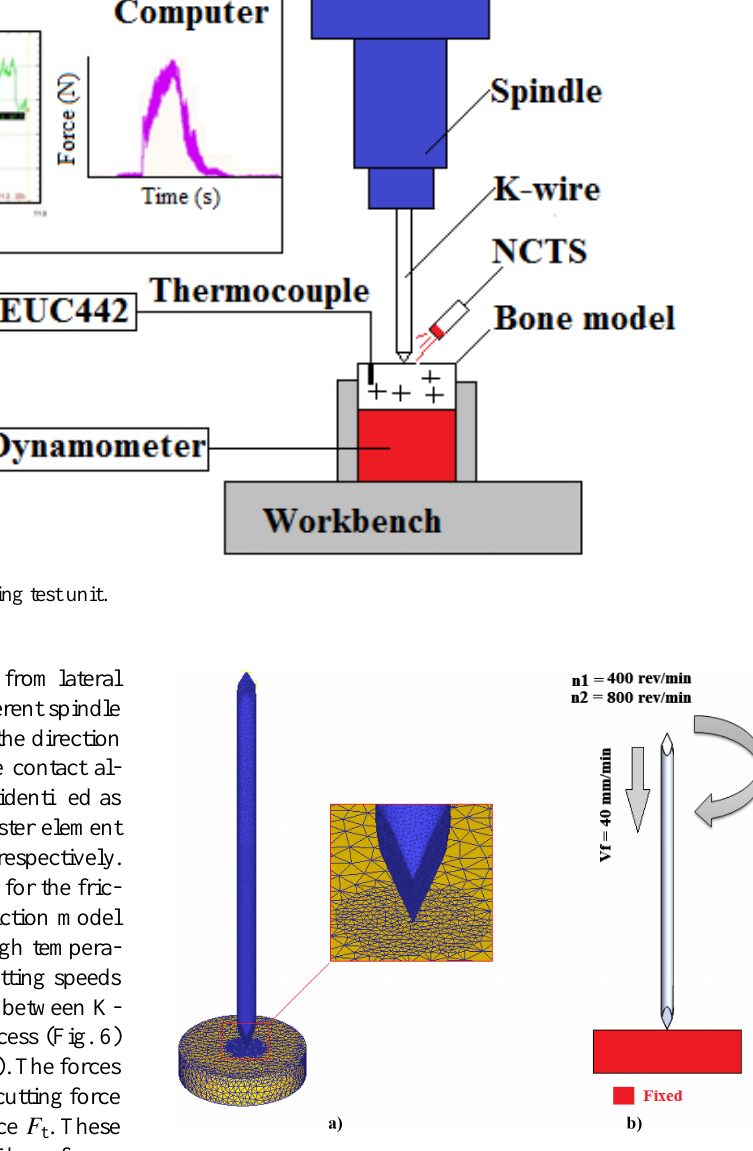
Figure 5. The structure of (a) bone model and K-wire as well as (b) boundary